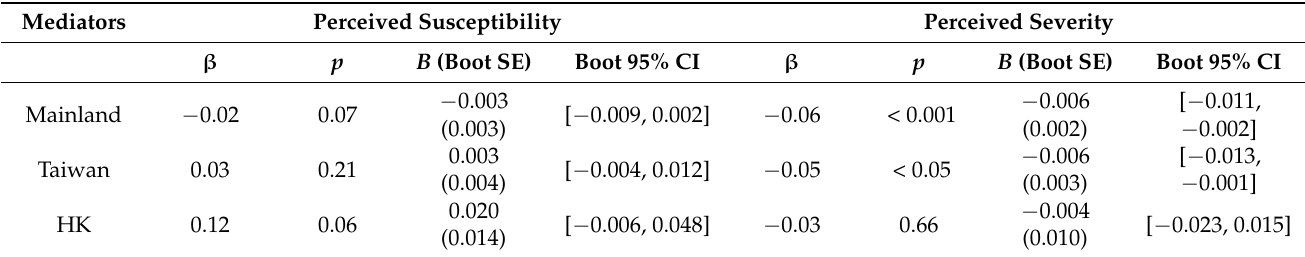
Table 4. Testing the moderated mediating effect of perceived threat on vaccination intention (Media trust as the moderator).